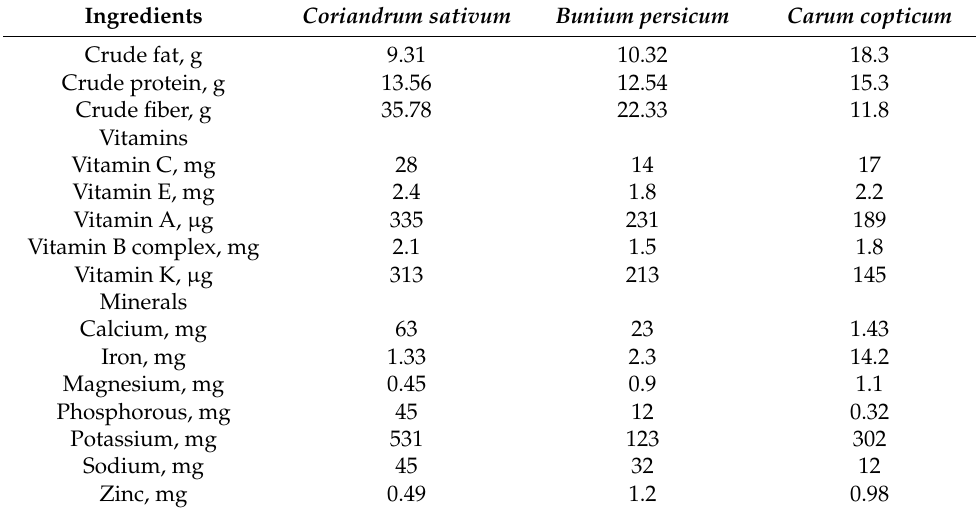
Table 2. Proximate analysis and chemical composition of seeds of Coriandrum sativum, Bunium persicum and Carum copticum (per 100 g sample w / w